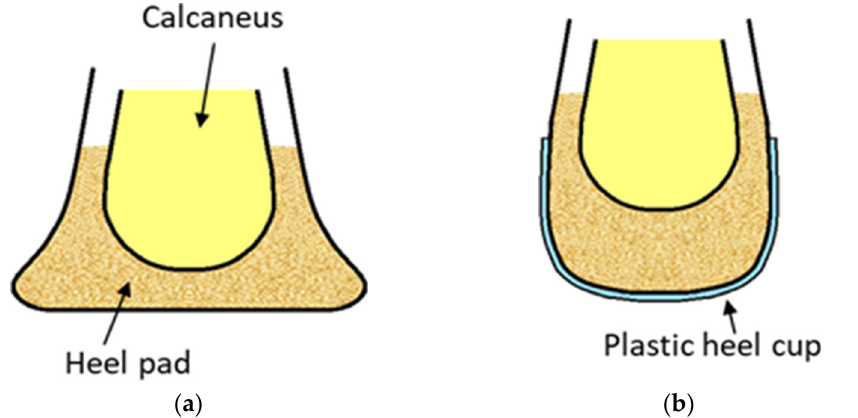
Figure 1. Illustration of plastic heel cup.